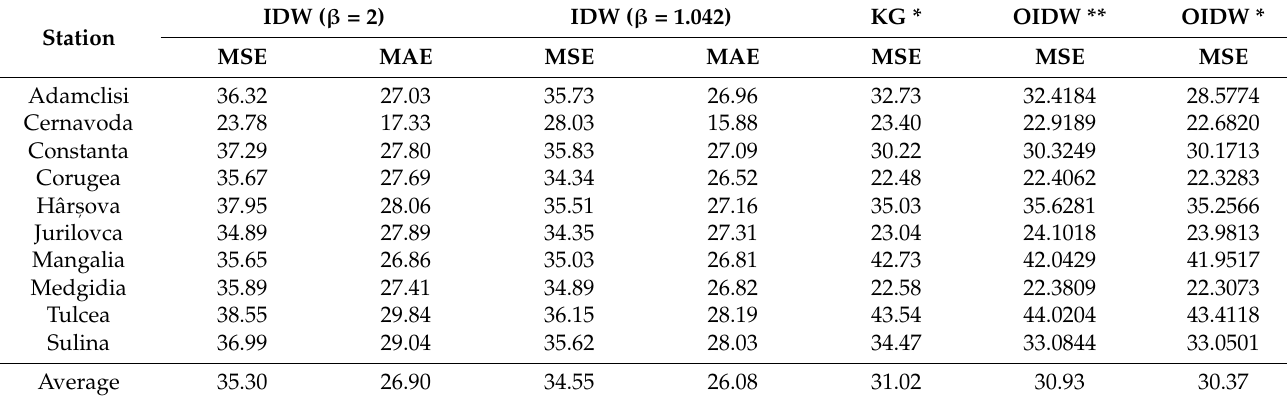
Table 7. MSE and MAE in the classical IDW for β = 2 and β = 1.042. MSE in ordinary kriging